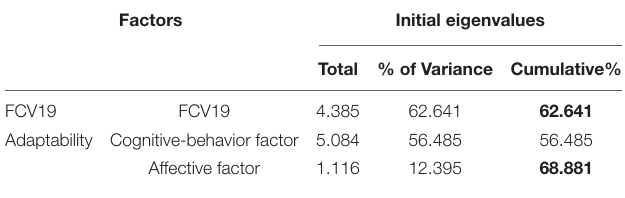
TABLE 1 | Total variance explained of the FCV19 scale and adaptability scale.